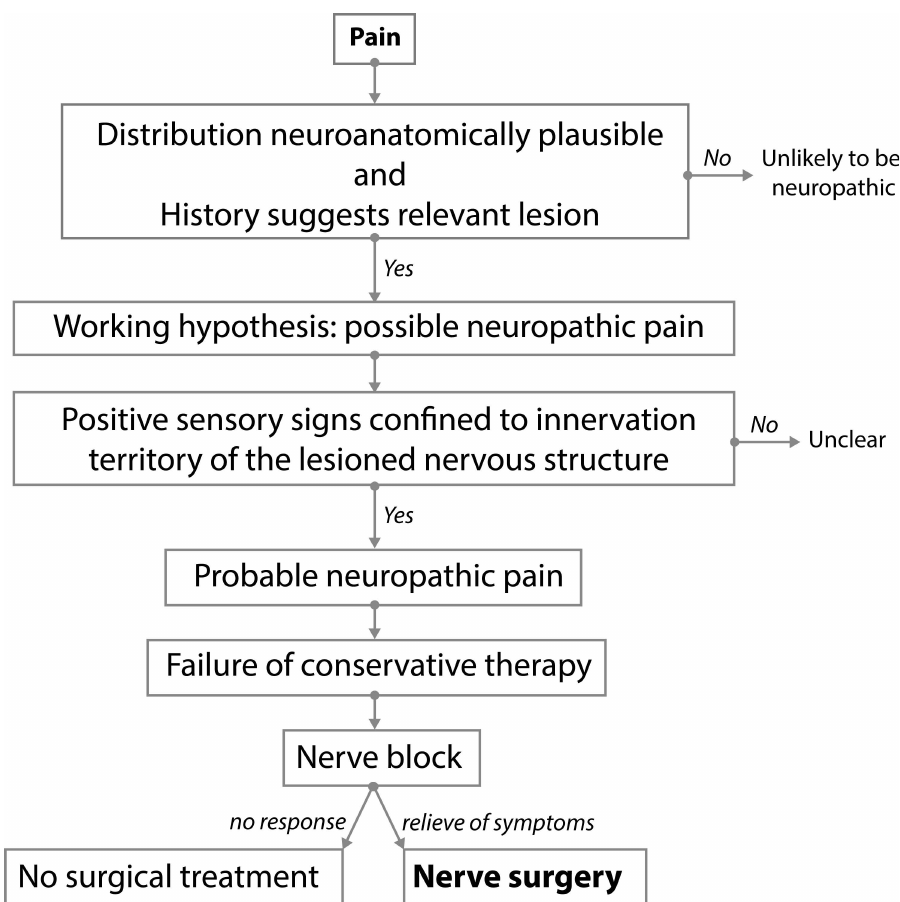
Fig 1. Current selection algorithm for nerve surgical treatment of patients with neuropathic pain due to a focal trauma to a nerve. The decision whether to operate or not is based on one “open” nerve block. Adequate temporary pain relief following the block is considered mandatory before surgery is undertaken. The nerve is then cut proximal to the painful area to obtain permanent pain